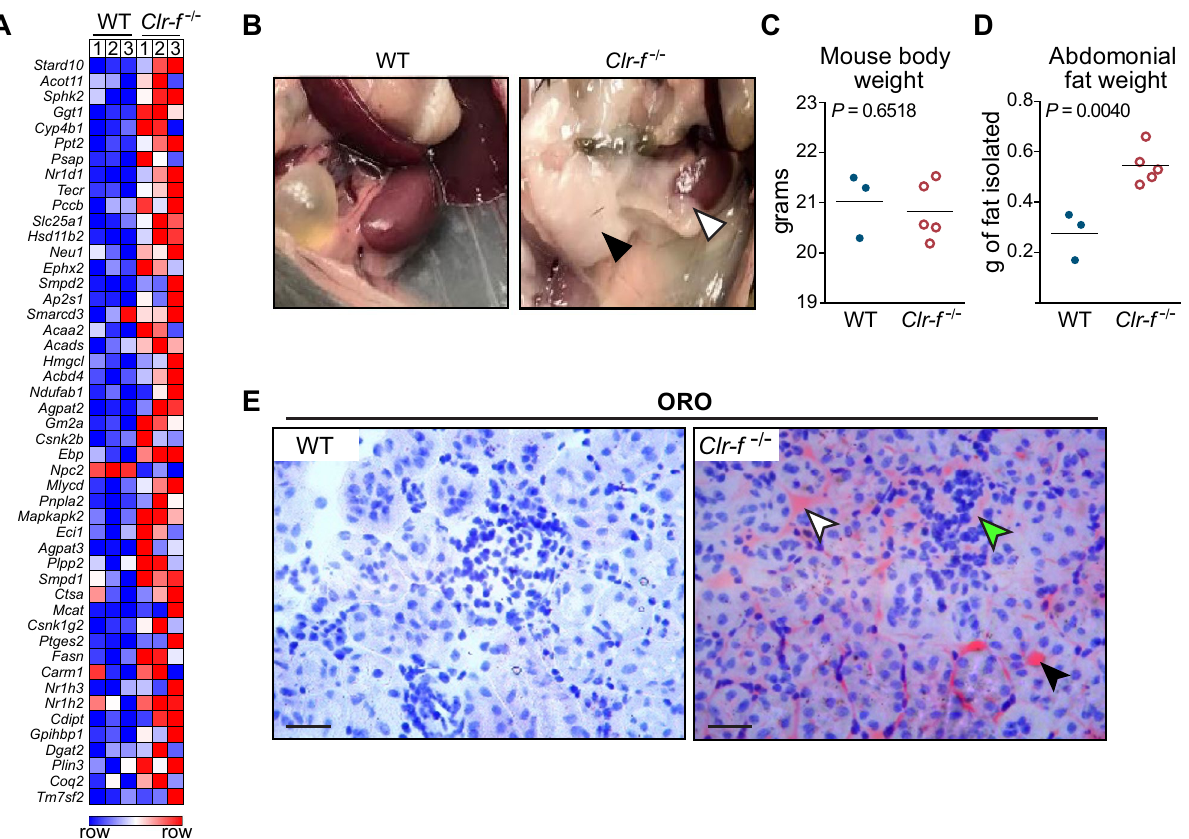
Figure 4. Clr-f −/− mice accumulate abdominal, perirenal and tubulointerstitial fat. ( A ) Heatmap comparing FPKM values of genes with roles in lipid metabolism between 13-week-old WT and Clr-f −/− mice. Heat map was constructed using Morpheus (https:// softw are. broad insti tute. org/ morph eus). ( B ) Exposed abdominal cavity of 24-week-old WT and Clr-f −/− mice. Abdominal fat is indicated by the black arrowhead, and perirenal fat is indicated by a white arrowhead. ( C ) Total bodyweight of 24-week-old WT and Clr-f −/− mice. ( D ) Weight measurements of total abdominal fat dissected from 24-week-old WT and Clr-f −/− mice. Horizontal bars represent mean weight. ( E ) ORO lipid staining of kidney tissues from 24-week-old WT and Clr-f −/− mice. White and black arrowheads indicate tubulointerstitial and luminal ORO staining, respectively, and the green arrowhead indicates glomerular ORO staining. Images are at 20 ×